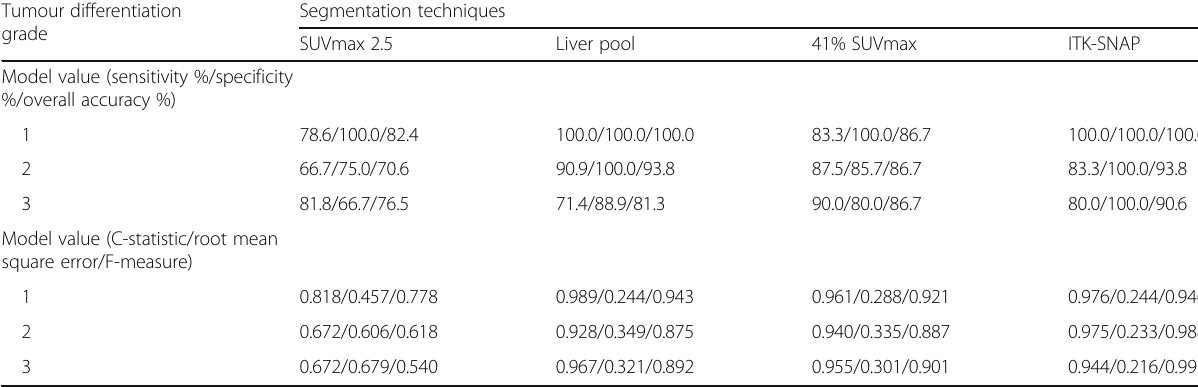
Table 2 Diagnostic accuracy of group method of data handling models to discriminate tumour differentiation grade in volumes from different segmentation techniques Tumour differentiation